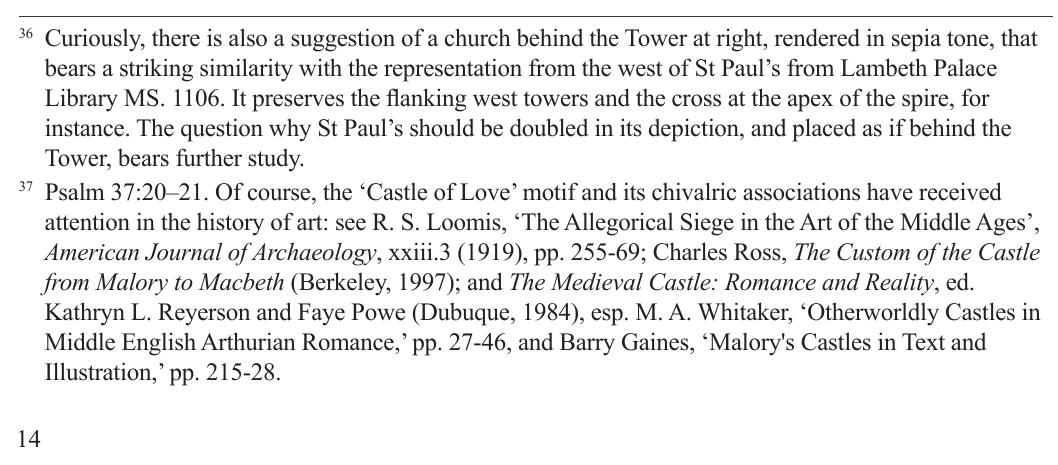
Fig. 11. Detail of the Castle of Love, c. 1325-40. The Luttrell Psalter, London, British Library, Add. MS. 42130, f.